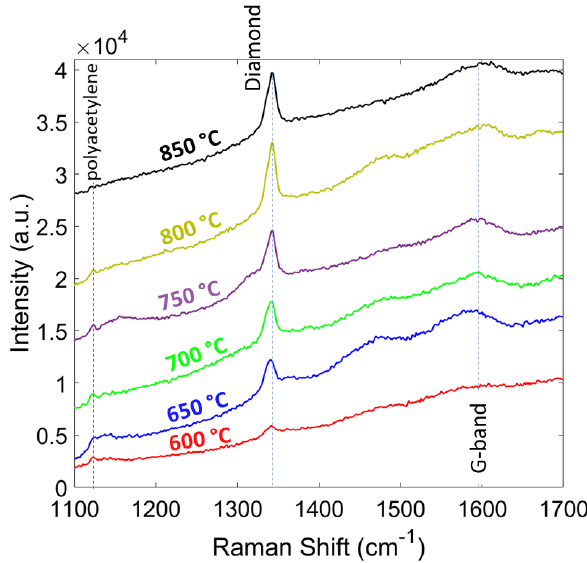
Figure 8. Raman spectra of the diamond films grown at different temperatures.